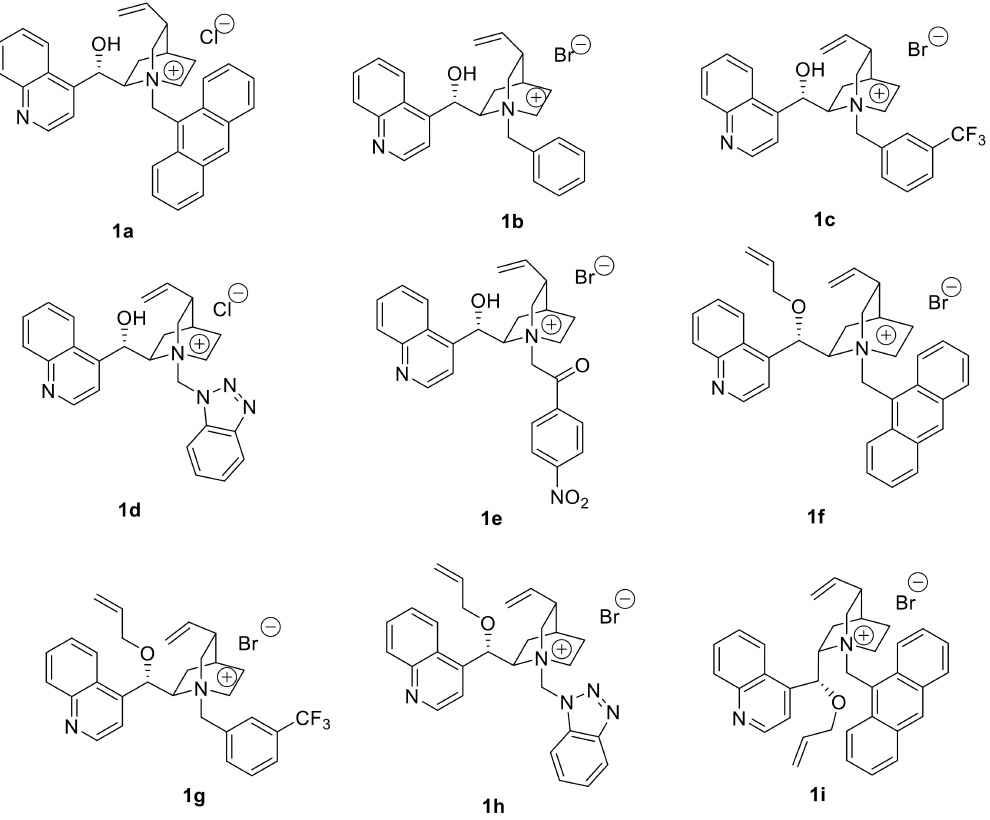
Figure 2. Catalysts 1a – 1i